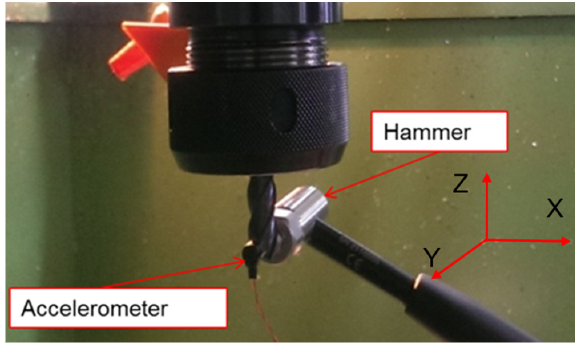
Figure 2. Dynamic parameter measurement of machine tool.